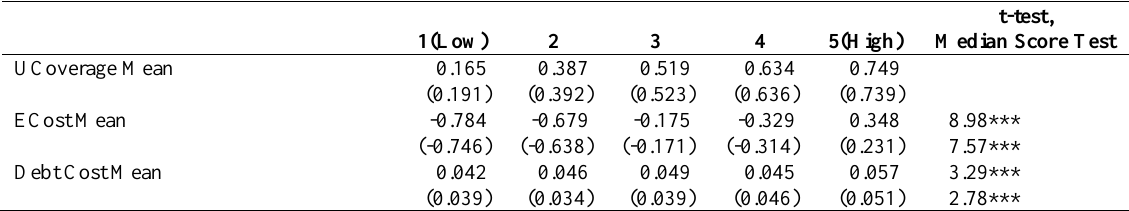
Table 4: The results over portfolios